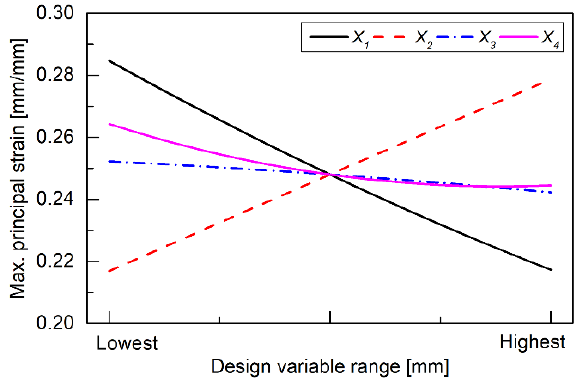
Figure 16. Design sensitivity analysis.